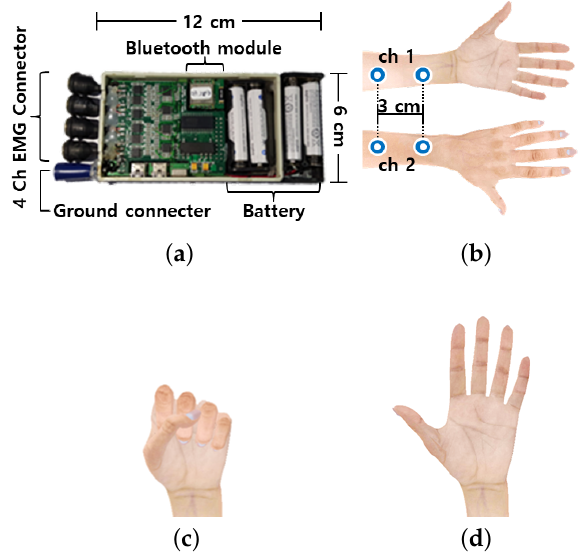
Figure 1. Wearable EMG sensing device and sensor location. ( a ) Wrist-type wearable device. ( b ) Location of two EMG sensors. ( c ) Hand-close. ( d )